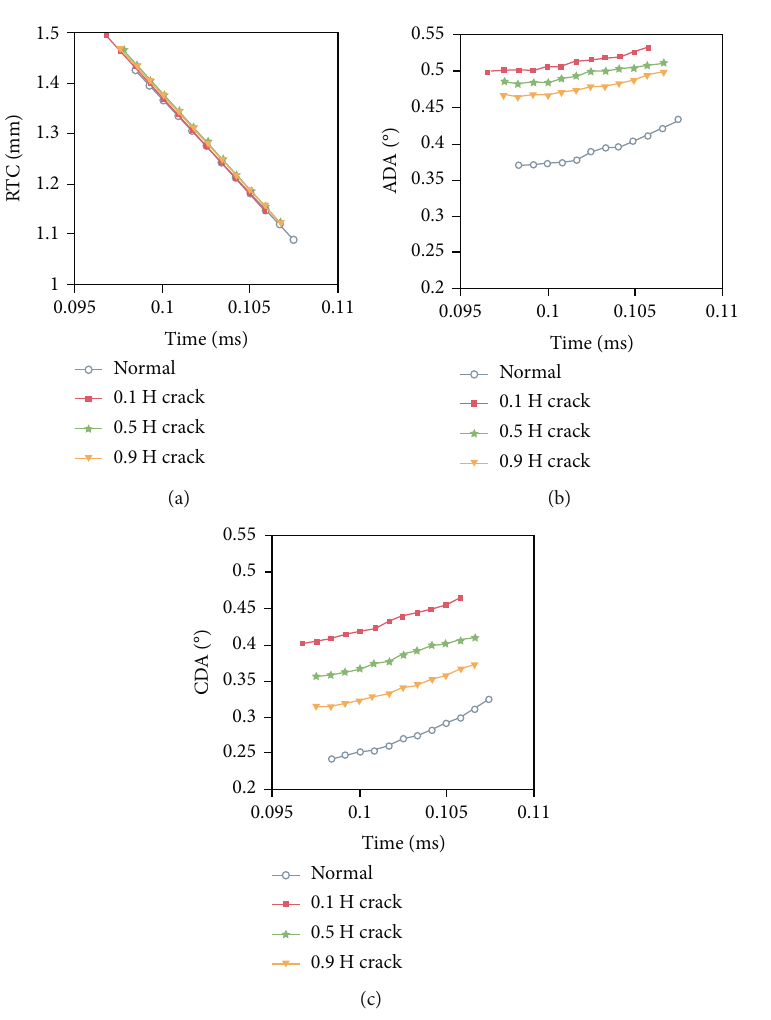
Figure 14: The 3D-BTC of blades with through-thickness cracks at di ff erent positions. (a) RTC. (b) ADA. (c)